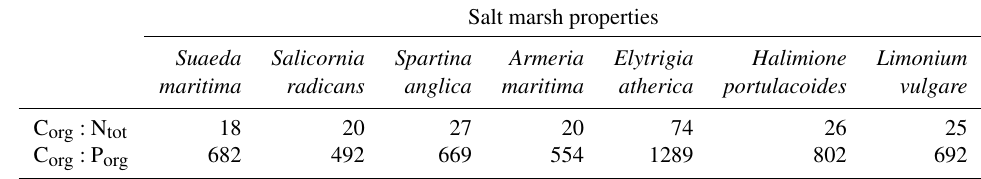
Table A3. Summary of salt marsh plant properties. Data were first published in van de Velde et al. (2020a).